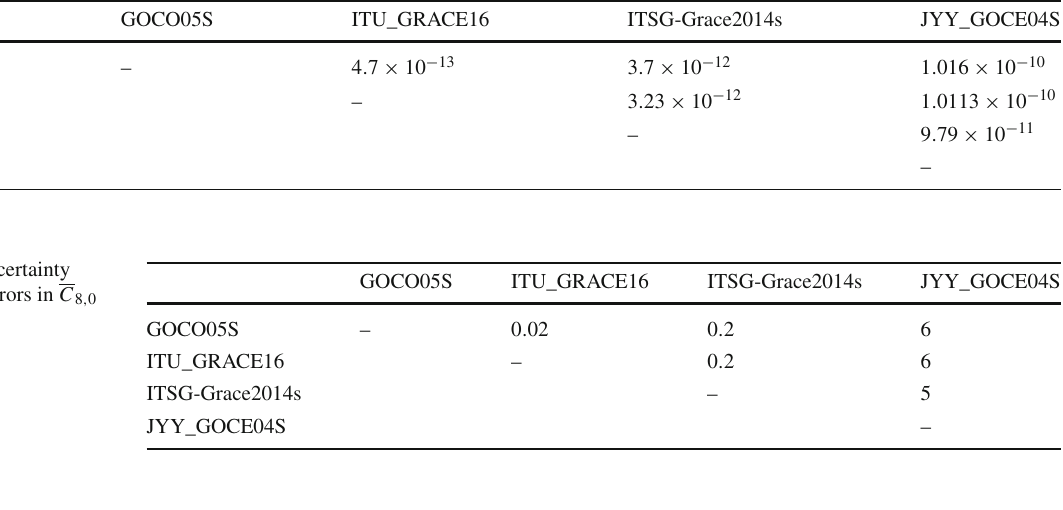
Table 5 Absolute values of the differences (cid:6) C 8 , 0 among the estimated values C 8 , 0 of the models of Table 2. They are very close to the uncer- tainties retrievable from the application of Eq. (A11) by Wagner and